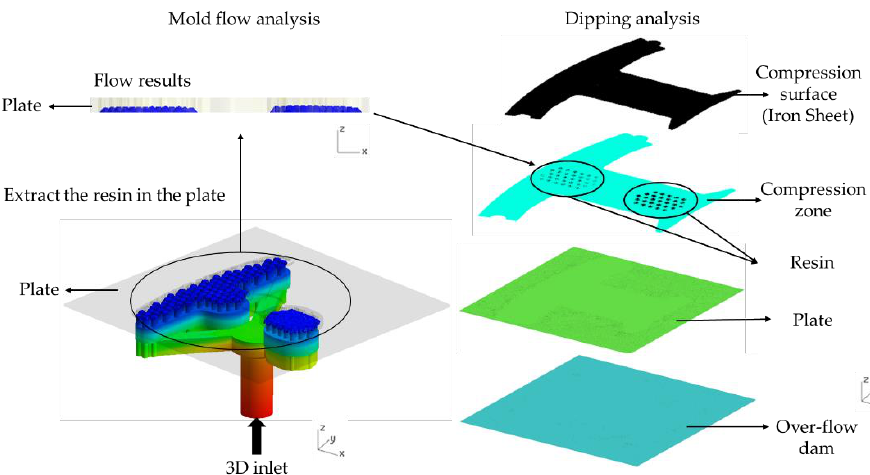
Figure 6. The simulation flow chart.